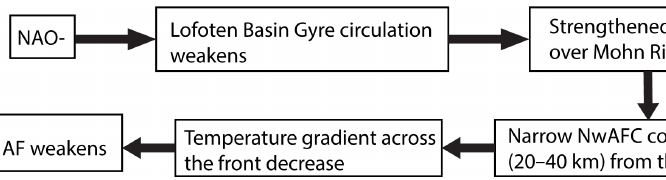
Figure 12. Graphical representation of the different processes associated with the weakening of the AF during NAO −